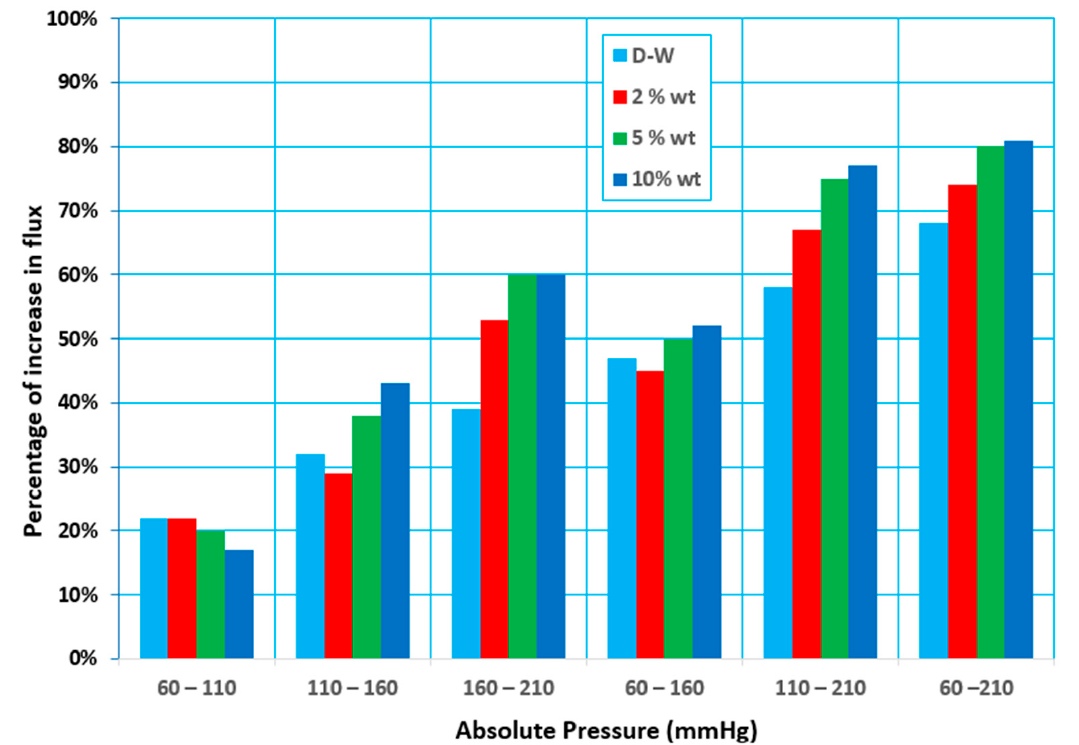
Figure 8. Percentage decrease in permeate flux with increasing absolute pressure at a feed temperature of 30 °C, a 0.6 L/min feed flow rate, and various concentrations.